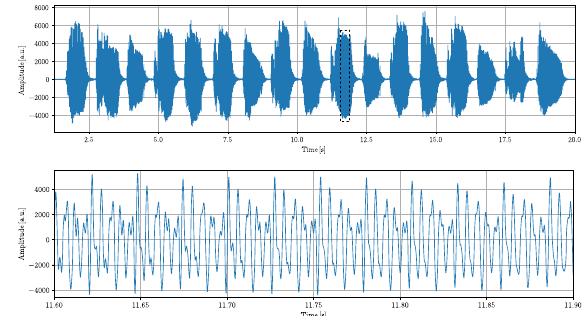
Figure 12. Top: shape of the time signal recorded from one tuba player playing the exercise described in Figure 11 on the B [ -contrabass tuba: each “ wavepacket ” corresponds to a note of the exercise. Bottom: details of the recorded signal of a ghost note played during the exercise, corresponding to the dashed box drawn in the top